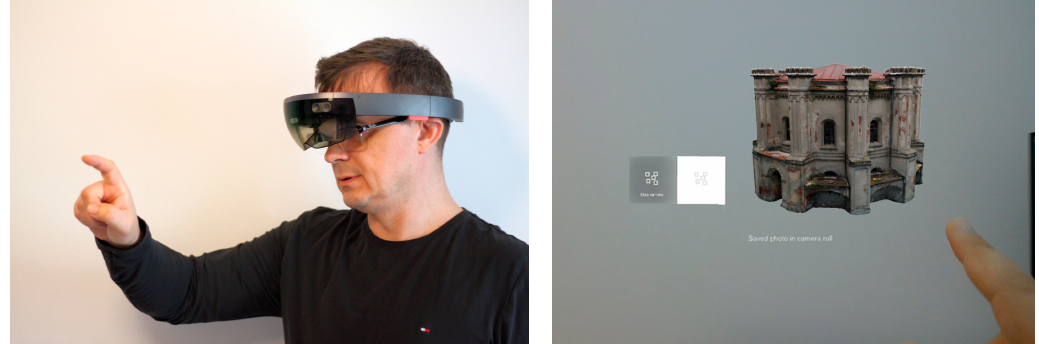
Figure 19. Visualization of the water station building model as a hologram using Microsoft Hololens MR helmet.